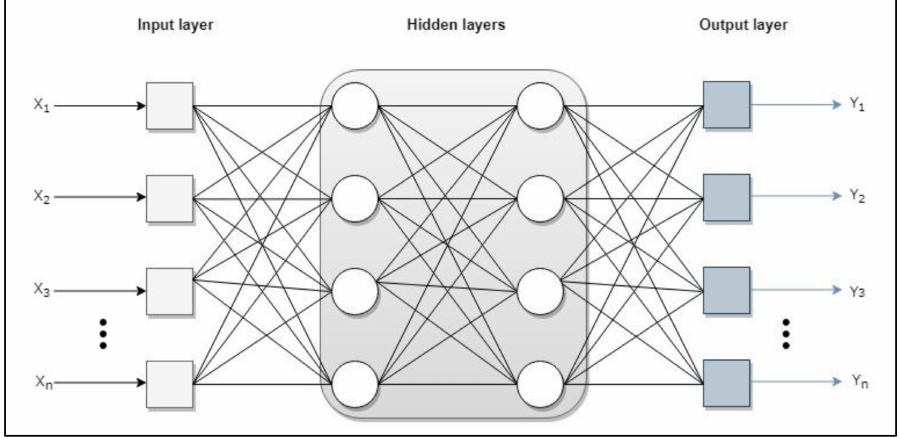
Figure A1. Topology of Multi-layer